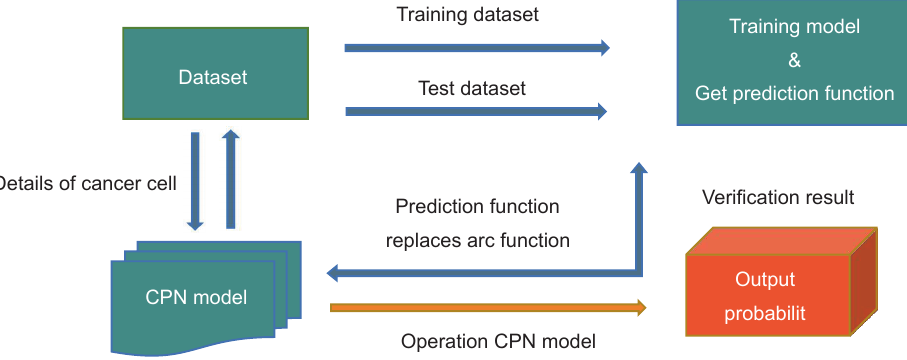
Fig. 1 Proposed research methodology to analyze and visualize breast cancer using